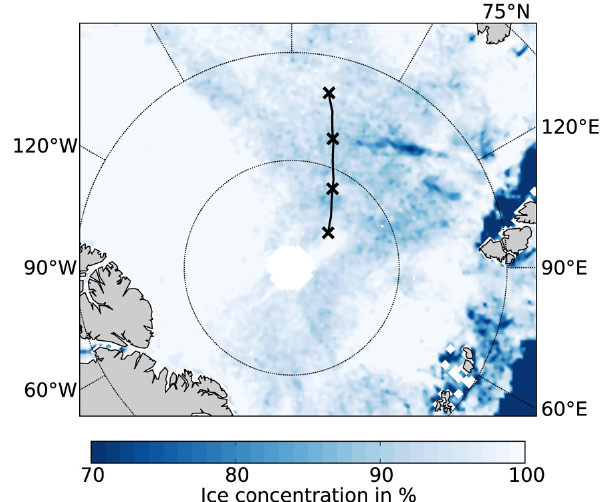
from 20 April 2007 12:00UTC during the last 30h arriving at Tara (black line).The differences between crosses are 10h. At this time Tara is located at 87.6 ◦ N, 134.9 ◦